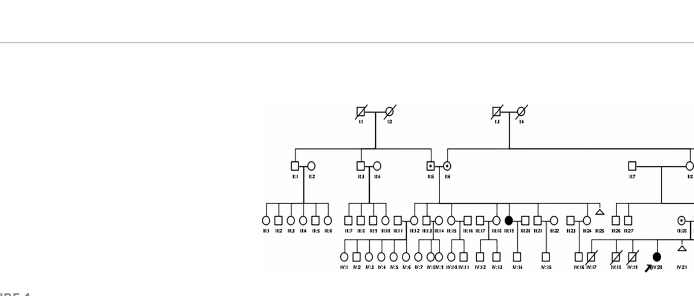
FIGURE 1 A large pedigree of the Indonesian family with CYP11B1 de fi ciency. Circles and squares indicate female and male gender identity, respectively, while diamond indicate sex undetermined.